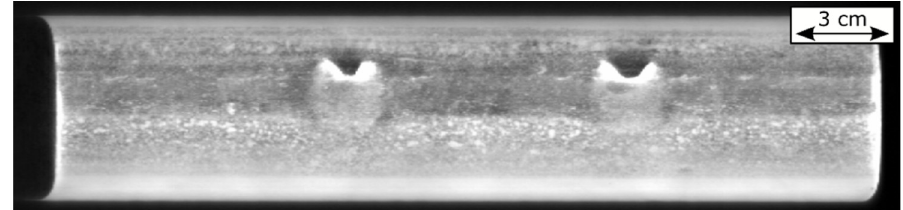
Figure 12. Temperature image of the specimen after re-organizing the pixel-columns.